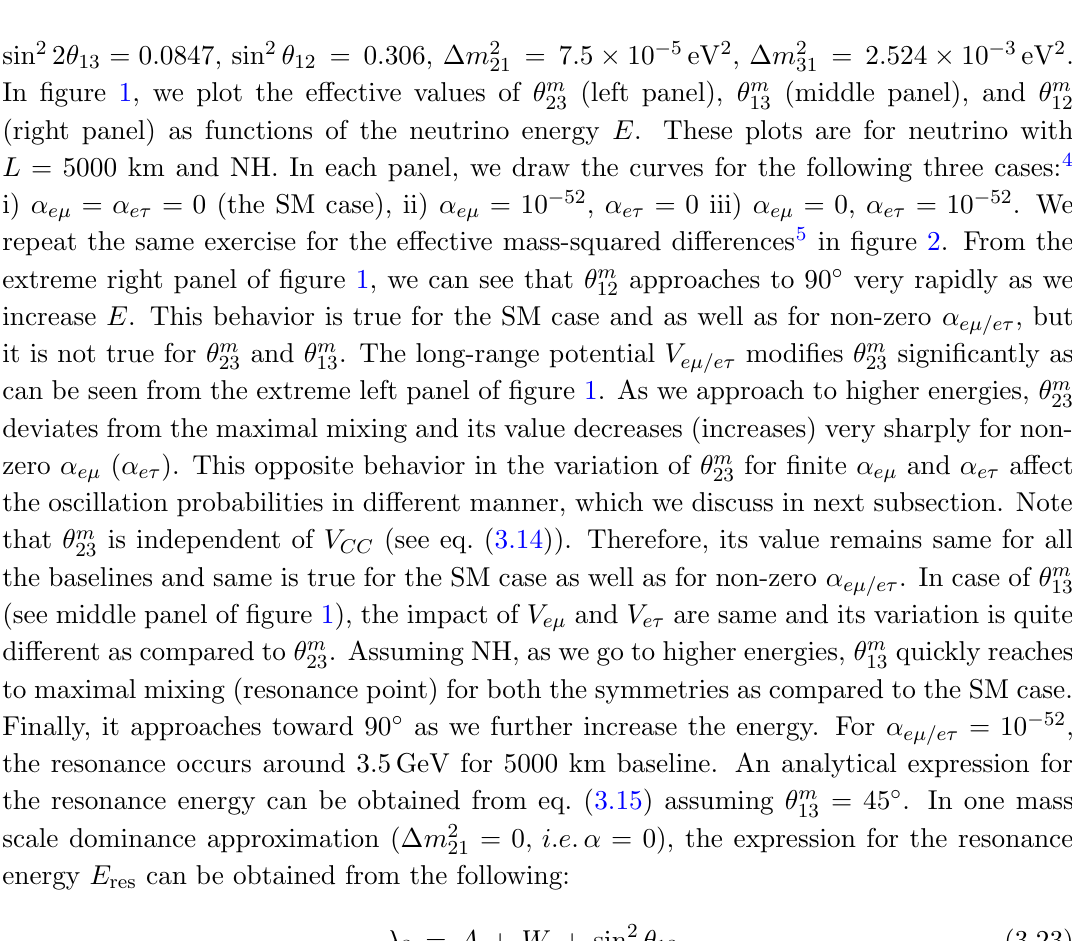
Figure 1 . The variations in the e(cid:11)ective mixing angles with the neutrino energy E in the presence of V CC and V . The left, middle, and right panels show the e(cid:11)ective value of (cid:18) m e(cid:22)=e(cid:28) respectively for L = 5000 km and NH. In each panel, the black solid line is for the SM case, whereas the blue dash-dotted and red dashed lines are for (cid:11) e(cid:22) = 10 (cid:0) 52 and (cid:11) e(cid:28) = 10 (cid:0) 52